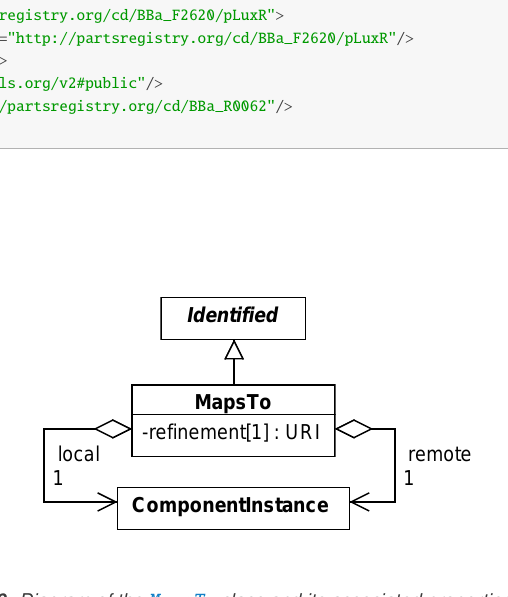
Figure 9: Diagram of the MapsTo class and its associated